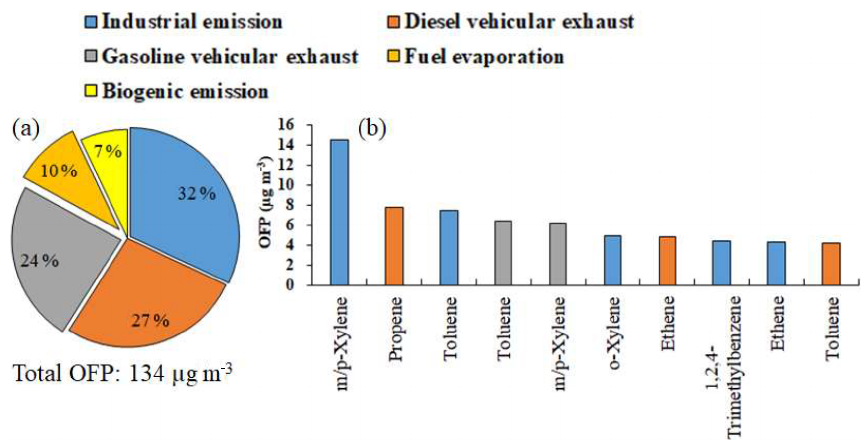
Figure 6. (a) The contribution of individual sources to the total OFP of all sources extracted from PMF and (b) OFP values of the top 10 VOC species in the different source